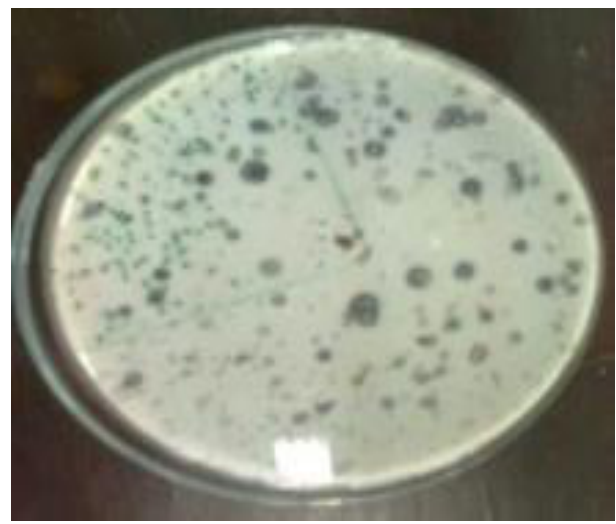
Figure 1. Lactid acid bacteria isolate grown in MRS + 0.5% CaCO 3 media.